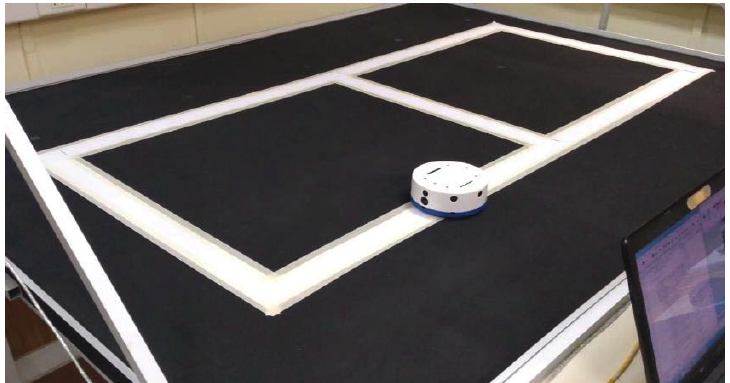
Figure 12. Track added to the platform to help the